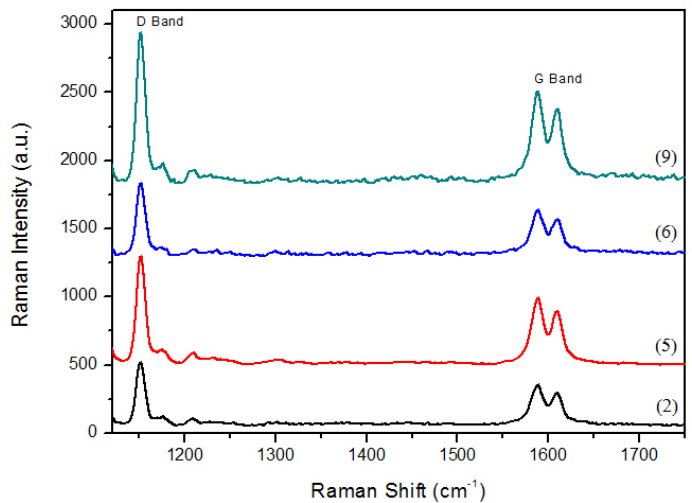
Figure 3. Raman analysis of PSU − CNT and PSU − GNP nanocomposites. Numbers (2), (5), (6), and (9) in parentheses correspond to sample IDs and compositions described in Table 1.